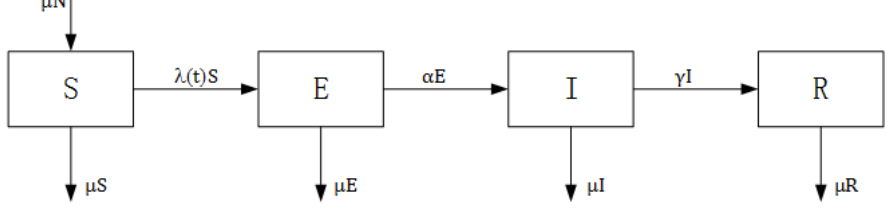
Figure 1. Structure of a susceptible-exposed-infectious-recovered (SEIR)